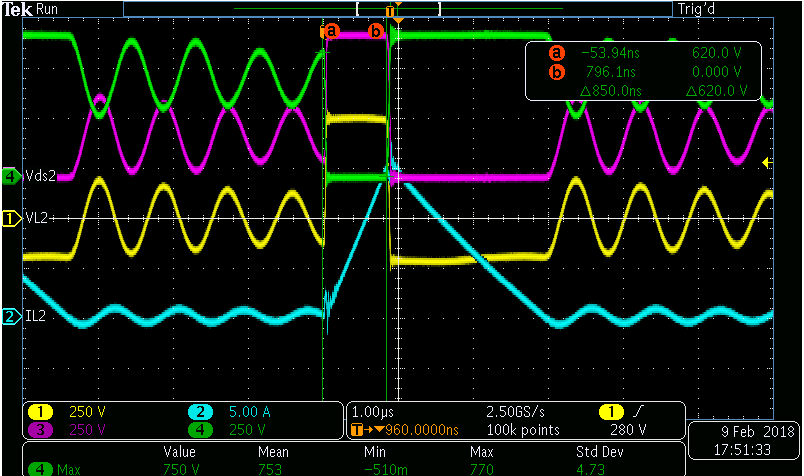
Figure 12. Oscilloscope screenshot. Prototype working at 700–200V 2187 W. Yellow trace is the phase inductor #2 voltage, the blue trace its current, the purple trace the diode reverse voltage and the green trace the MOSFET drain-source voltage.